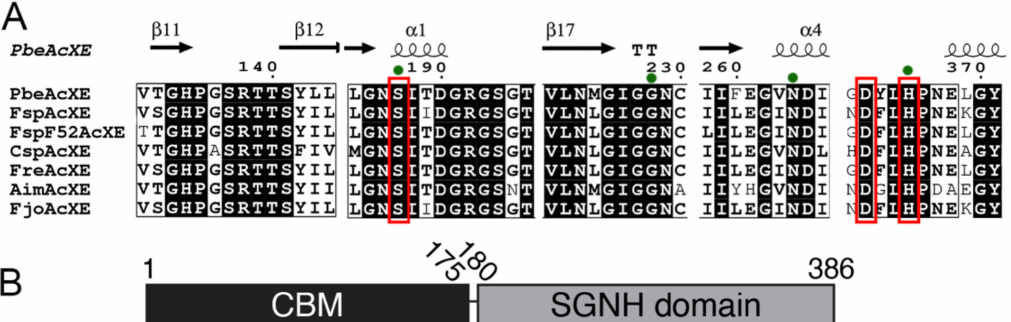
Figure 1. ( A ) Partial alignment of selected sequences and the biochemically characterized Fjo AcXE from Flavobacterium johnsoniae (Razeq et al., 2018) [27]. Catalytic residues are rounded with red and the SGNH residues of the SGNH blocks are marked with green dots above columns. The amino acid numbering showed above columns are from Fsp AcXE sequence, including signal sequence.